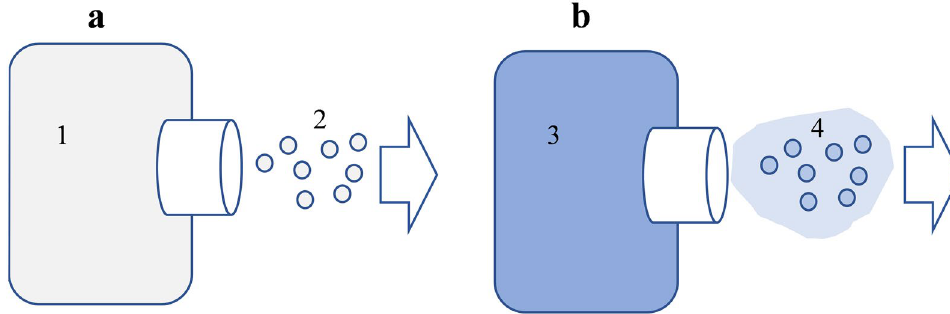
Figure 6. Schematic comparison of aerosol generated from ( a ) water and ( b ) ADON: 1—water in a nebulizer (with equilibrium concentration of dissolved oxygen), 2—aerosol formed by droplets of water in the air, 3— ADON (with increased oxygen concentration) in a nebulizer, 4—ADON droplets surrounded by air with increased oxygen concentration after partial desorption of this gas from ADON